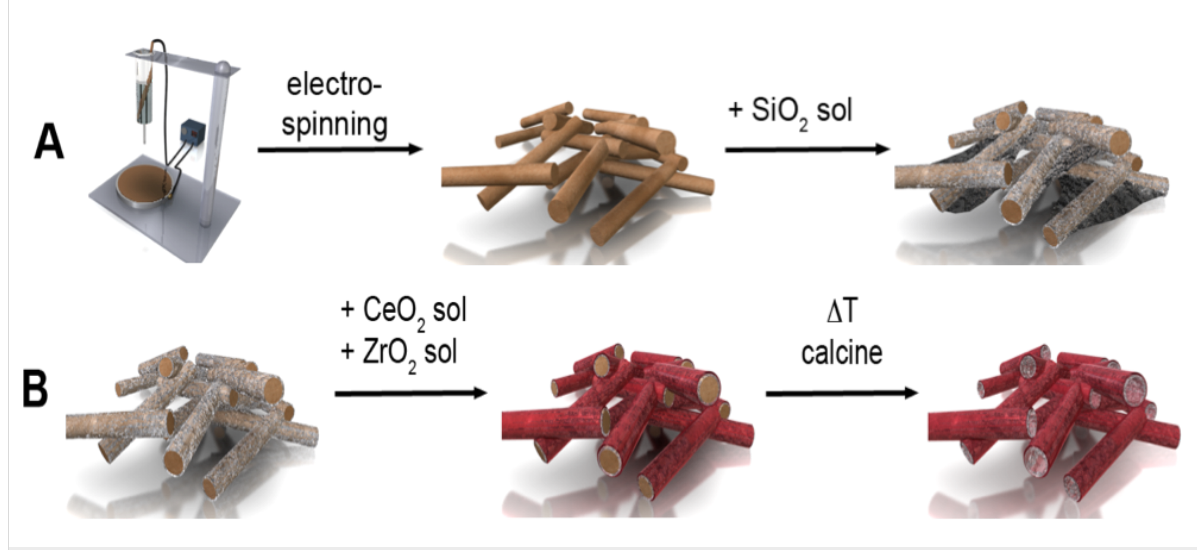
Scheme 1: Reaction sequence starting from an electrospinning process yielding PS fibers, followed by the subsequent deposition of silica, ceria and zirconia sol formulations and the drying of the deposits. The final calcination removes the inside PS template fibers (shown in brown) to yield ceramic oxide composite tubes of the composition ceria/zirconia@silica.